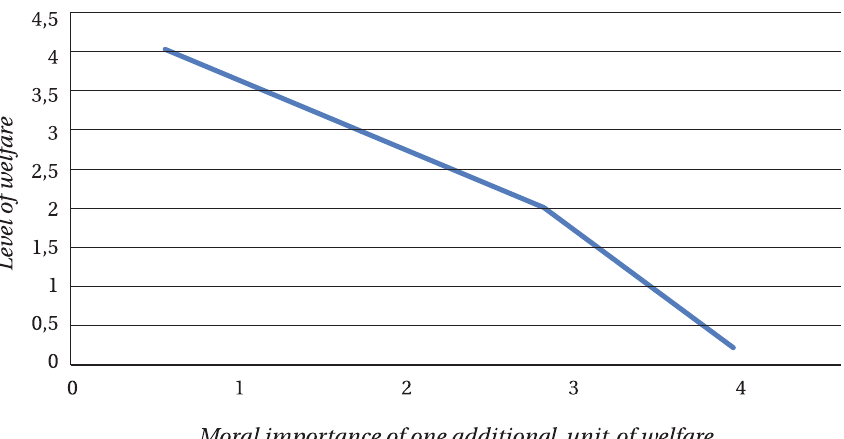
Figure 2.2. Non-uniform